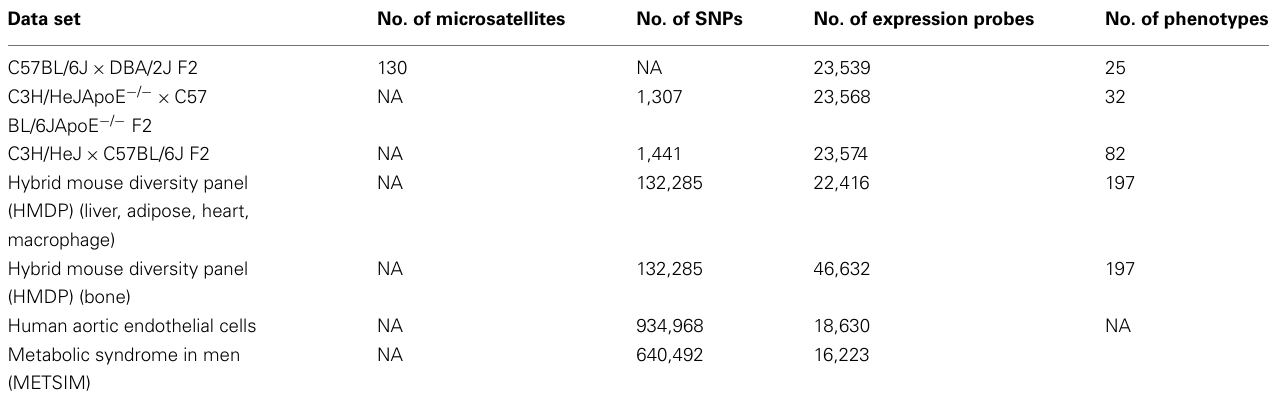
Table 2 | Summary of clinical phenotypes and intermediate phenotypes contained in the